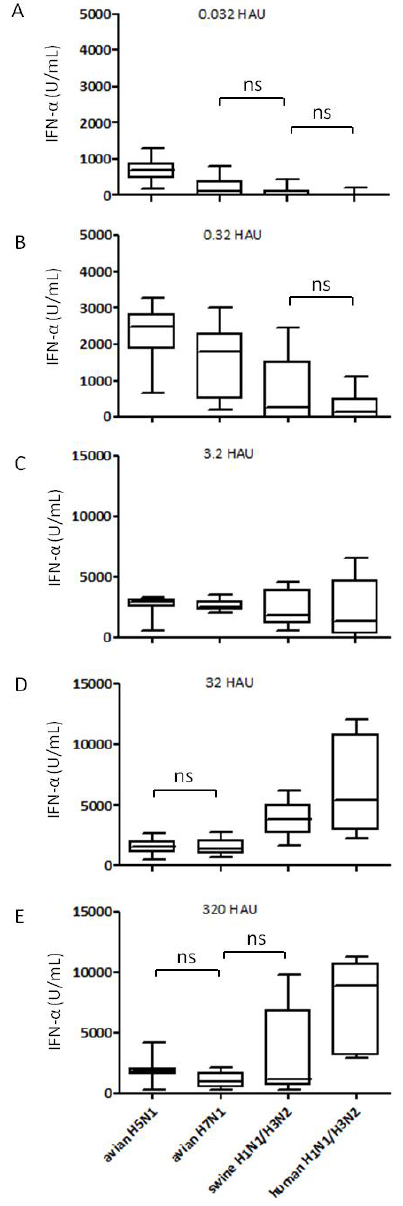
Figure 2. Comparative analysis of the interferogenic profiles of avian, human and swine IAV. Porcine pDC were stimulated with six different avian (H5 and H7), three human and three swine IAV (all listed in Table 1), and IFN-α in the supernatants was quantified by ELISA after 24 h. ( A , B ) Box plots analysis for triplicate cultures stimulated with low HAU dose of 0.032 or 0.32 (y-axis maximum 5000). ( C , D , E ) Box plots for moderate-to-high virus doses of 3.2, 32 and 320 HAU (y-axis maximum 15000). Each box was calculated from data pooled for the indicated groups (three different viruses per group, each tested in triplicate wells). Box plots analysis display data as the median and 25th and 75th percentiles and error bars the 95% confidence interval. Statistics and p values were calculated using GraphPadPrism5 Software [9]. One way repeated analysis of variance (ANOVA) was used and Bonferroni’s multiple comparisons in between the groups. Within one graph all groups are statistically different except those labeled with ns (not